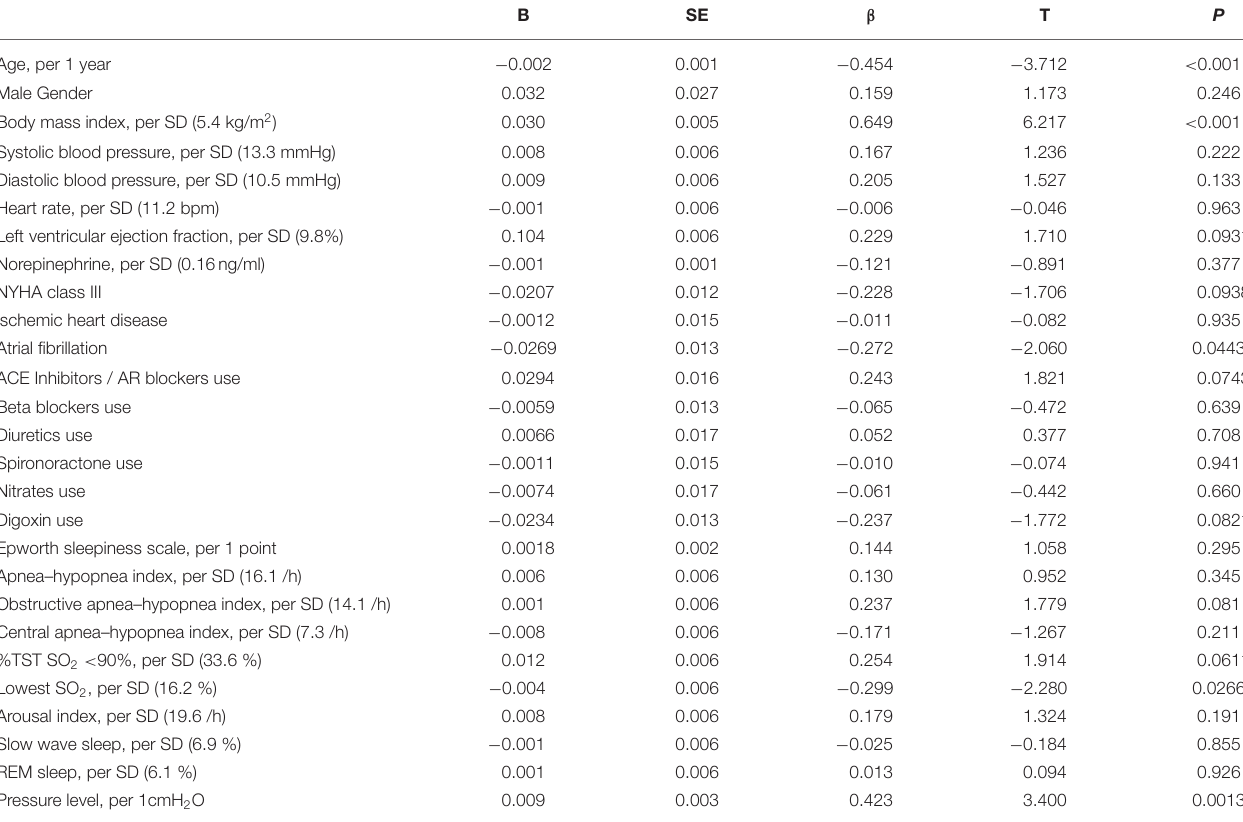
TABLE 3 | Univariate regression analysis for baseline variables associated with the improvement of LVEF.